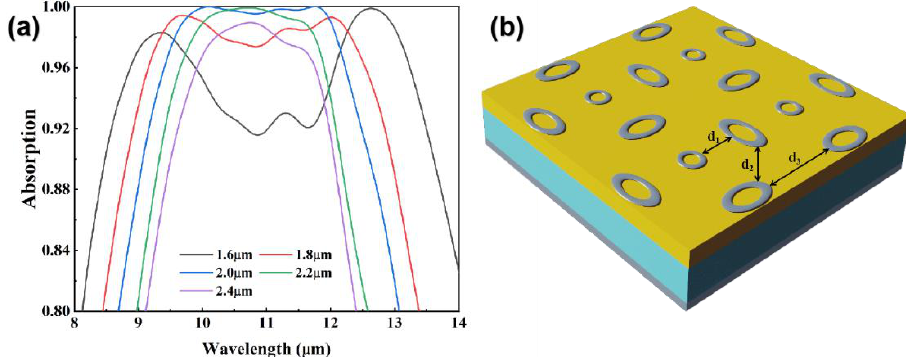
Figure 5. ( a )Absorption spectra with different period sizes. ( b ) Schematic diagram of the designed meta-structure absorber. Three parameters: d 1 —distance between ring and elliptical ring; d 2 —distance between adjacent elliptical rings in different directions; d 3 —distance between adjacent elliptical rings in the same direction.